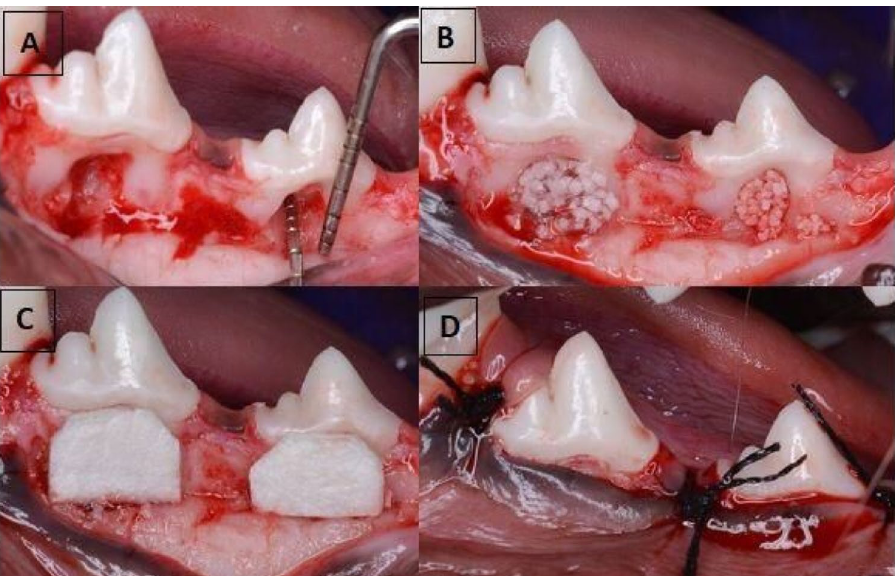
Figure 1. (A) The use of the periodontal probe to measure the vertical and horizontal dimensions of the surgically induced class II furcation defect in mandibular third (P3) and fourth (P4) premolars. ( B) P3 defect filled with β-TCP only and P4 filled with β-TCP mixed in Aloe vera gel ( C) Adaptation of trimmed collagen membranes over the grafted defects ( D) Proper closure of the defects by the interproximal interrupted